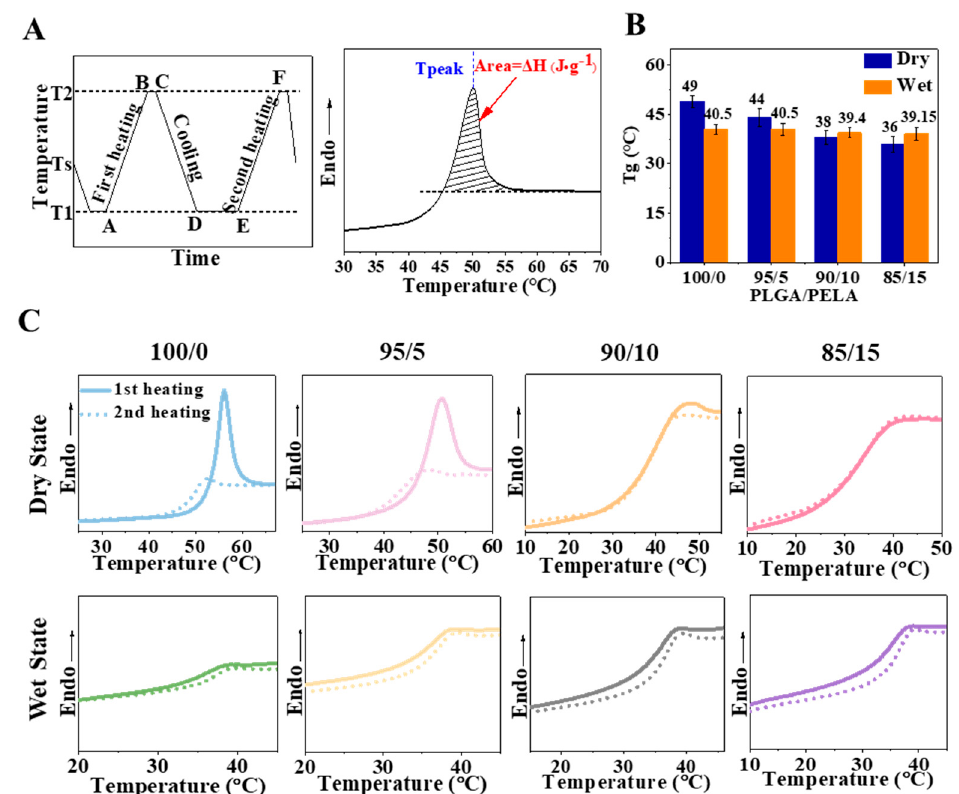
Figure 4. Glass transition and enthalpy change of fibrous membrane. ( A ) Program of DSC process ( left ) and determination of peak temperature and enthalpy change from DSC curve ( right ). T1, Ts, and T2 were 0, 40 (standby temperature), and 80 °C, respectively. ( B ) The glass transition temperature of the fibrous membrane in the dry and wet state. ( C ) DSC curve of the fibrous membrane in the dry state ( top ) and wet state ( bottom ).